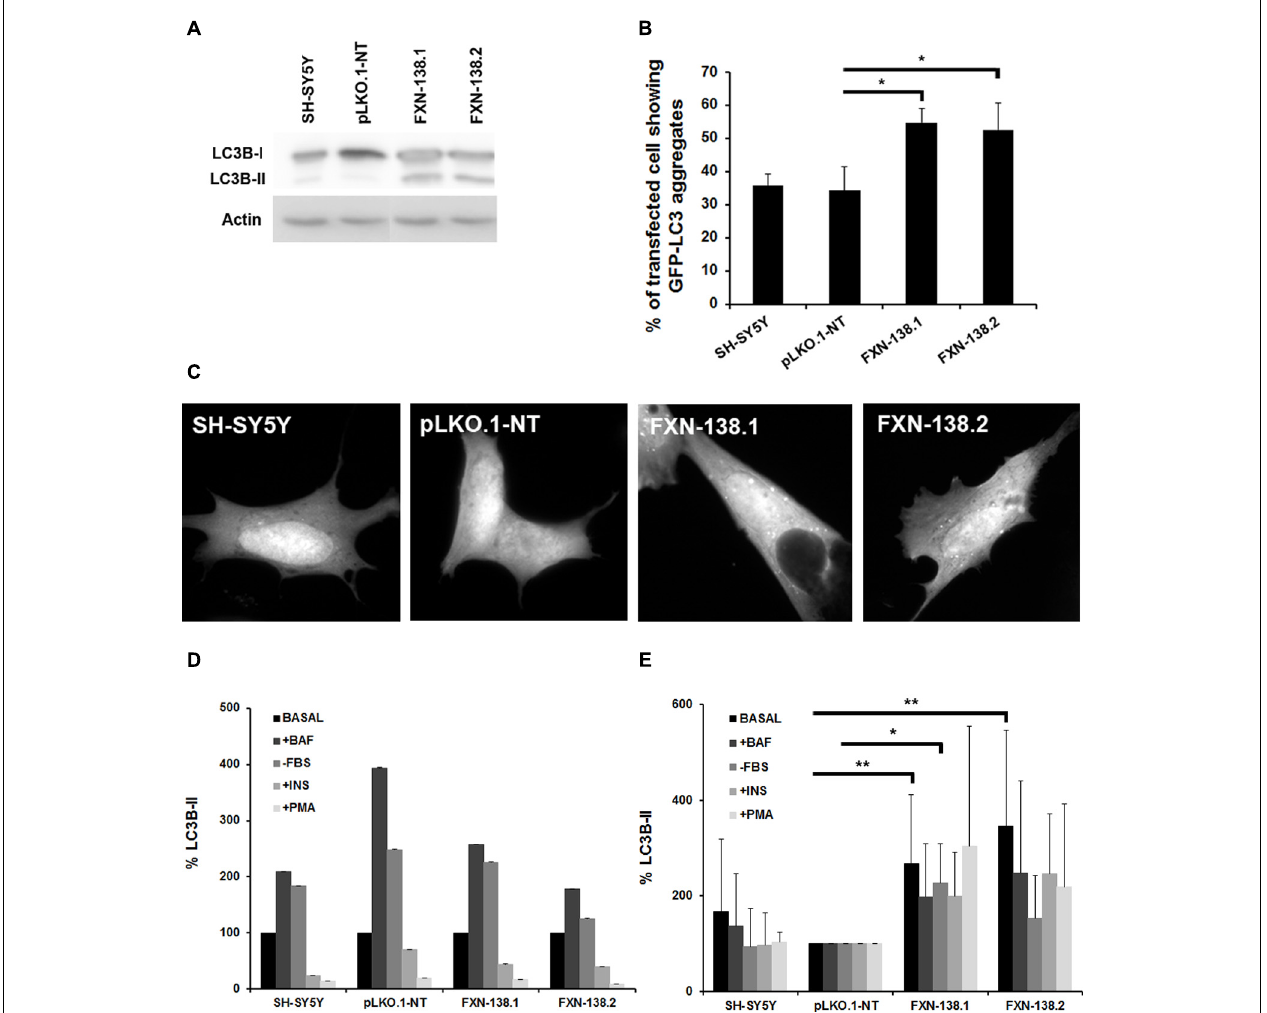
FIGURE 8 | Effects of frataxin deficiency on the autophagy process. (A) Western blotting using anti-microtubule chain 3 (LC3) antibody.We detected LC3-I conversion and LC3-II turnover.The figure shows an increase level of LC3-II in FXN -deficient cells. Results are representative of five experiments. Proteins were quantified for each lane using Fujifilm’s Multi-Gauge Software. To allow for loading variation, values were normalized to the actin control. (C) Cells were transfected with EGFP-LC3 and, after culturing for an additional 24 h in complete medium, were examined by confocal fluorescence microscopy. Frataxin depletion increased GFP-LC3 puncta in SH-SY5Y cells, while puncta were not found in GFP control cells. (B) The percentage of cells showing GFP-LC3 aggregates was quantified. Data are means ± standard deviations from three independent experiments. At least 300 cells were analyzed for each. Student’s t -test, FXN-138.1 p = 0.021, FXN-138.2